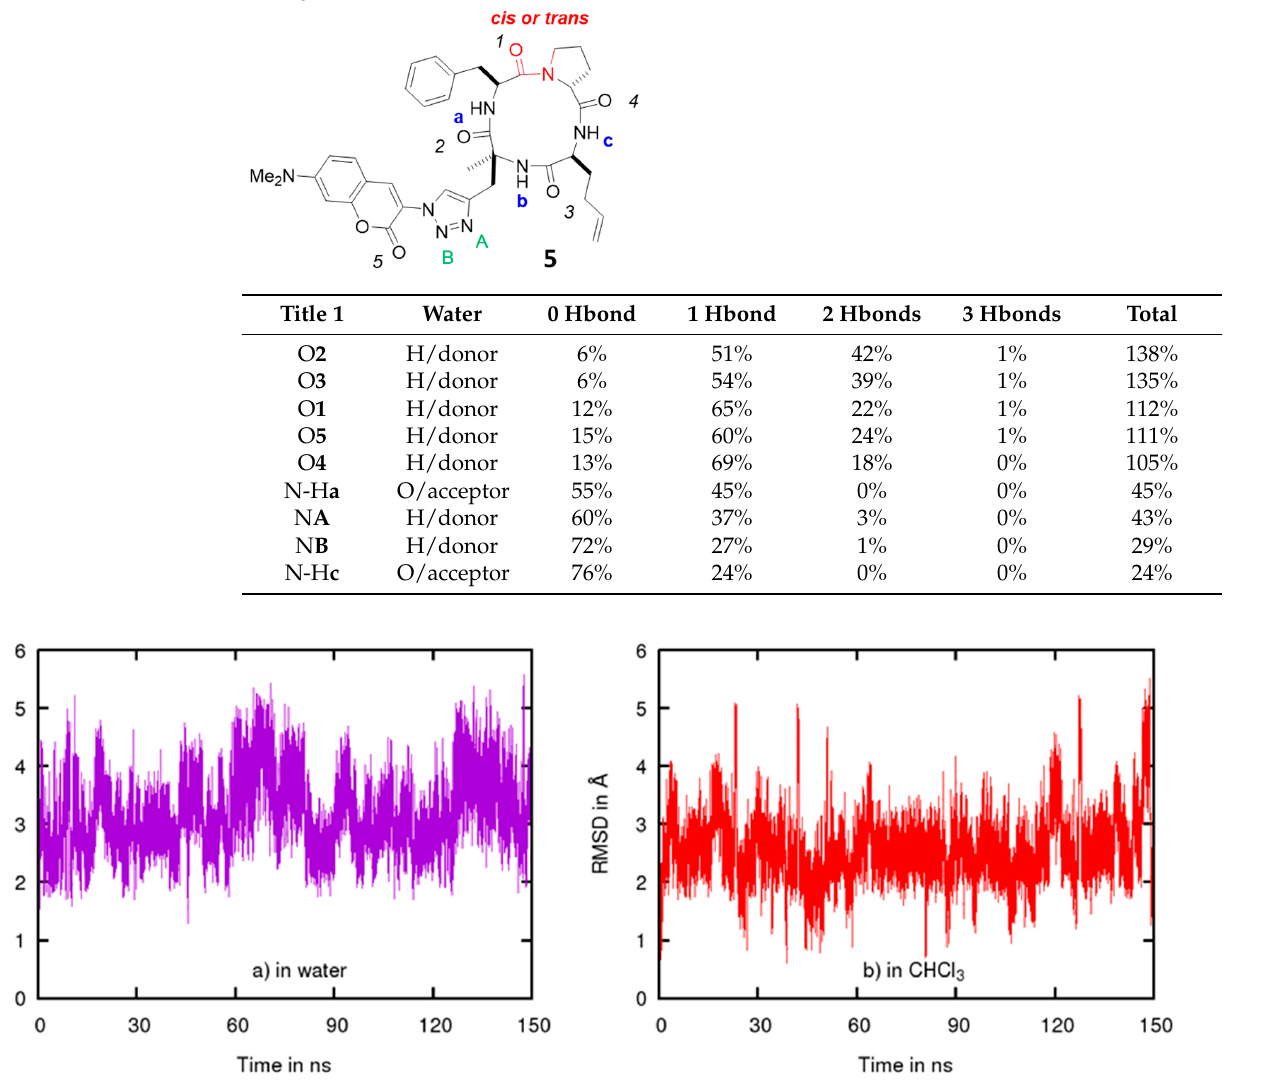
Table 3. Percentage of the presence of hydrogen bond (Hbond) between water and compound 5 during the simulation.